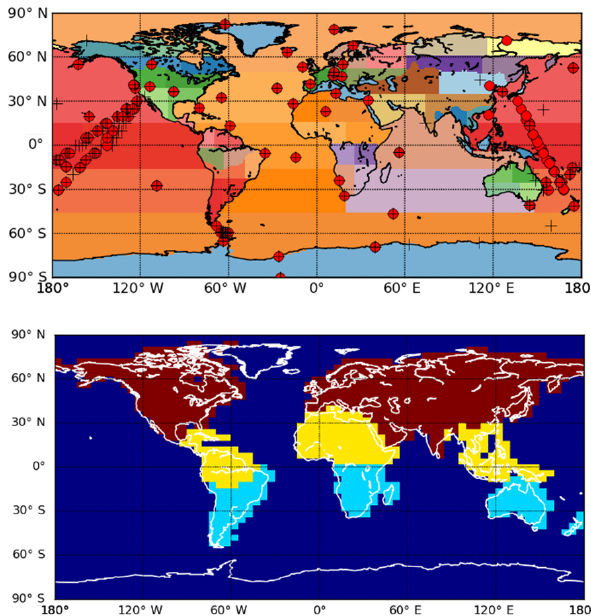
Figure 1. Top panel indicates the geographic basis functions used in our CO 2 and CH 4 flux inversion experiments. There are 44 land and 11 ocean regions. The red dots and the black crosses represent the locations of the NOAA in situ CO 2 and CH 4 observations that we assimilate in both the ratio inversion and the in situ only inversion. Geographical regions are based on those used by the TransCom ex- periments (Gurney et al., 2002), but we split each TransCom land region into four subregions denoted by different colours. Bottom panel indicates the definition of the aggregated northern (red), trop- ical (yellow), and southern (light blue) land